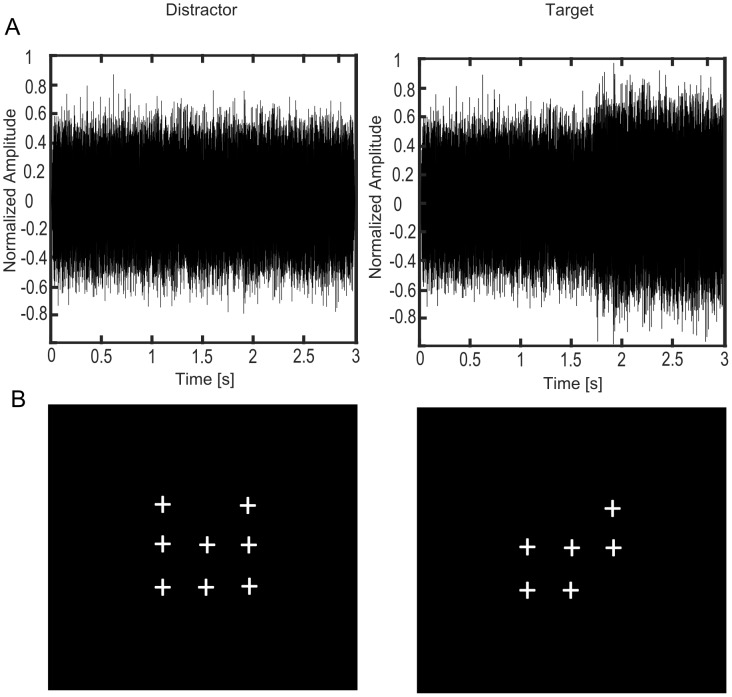
Depiction of target and distractor stimuli for the visual and auditory tasks.(A) Auditory distractor and target: Small changes of loudness (increase of 2 dB) were implemented as the target masking sound. This loudness change could occur on four different time points during the presentation of the masking stimulus (0.5 s, 1.1 s, 1.7 s, 2.6 s) and lasted until the end of the masking stimulus. The depiction shows a loudness change at 1.7 s. (B) Visual distractor and target stimuli: When the pattern of small crosses displayed exactly one small square of crosses, the stimuli were considered as targets.